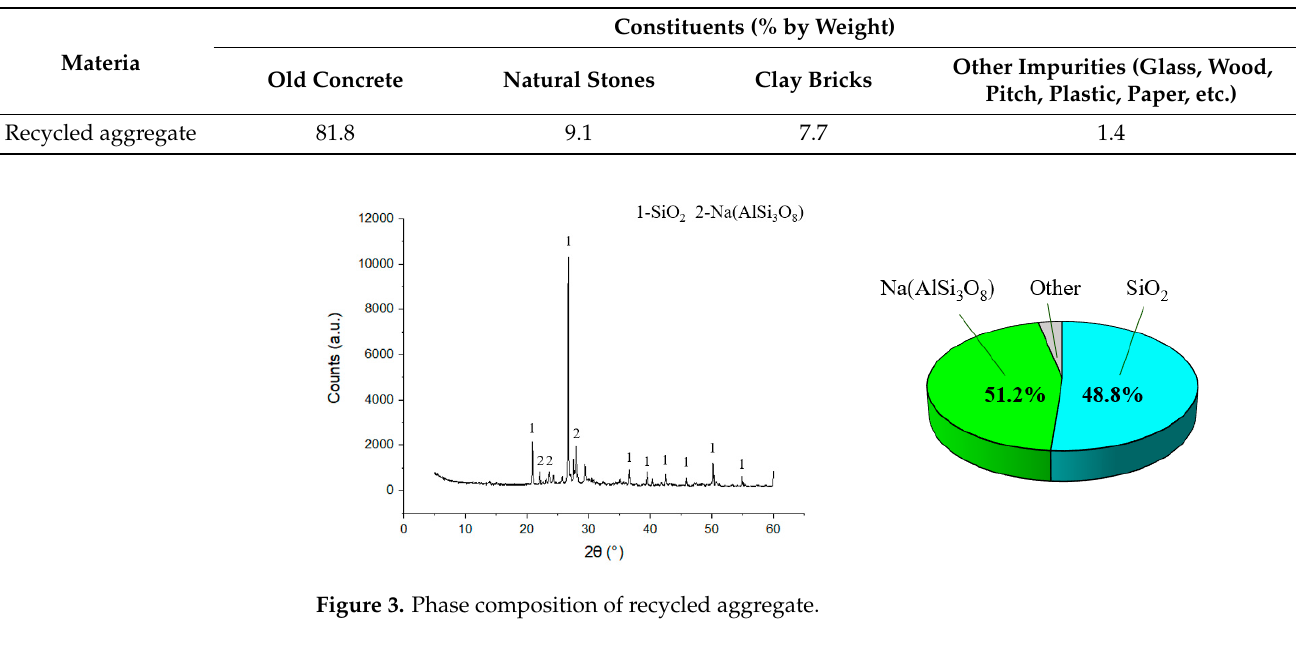
Figure 3. Phase composition of recycled aggregate.